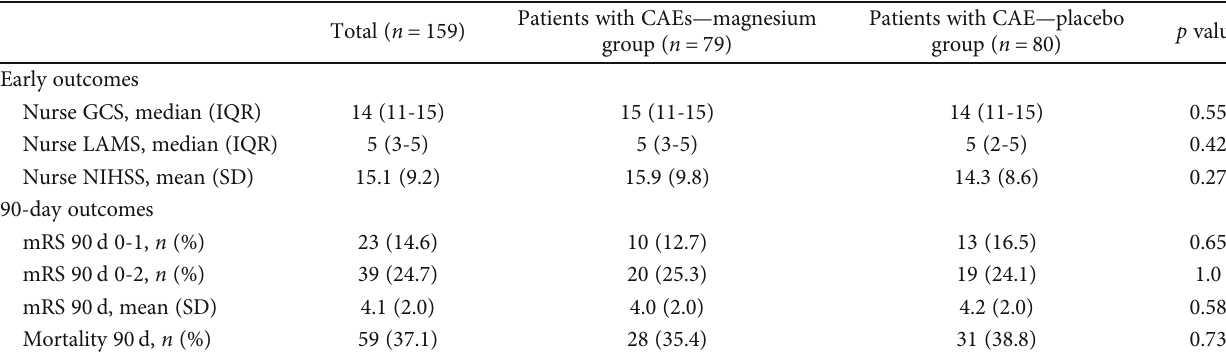
Table 5: Outcomes for patients with CAEs in magnesium and placebo